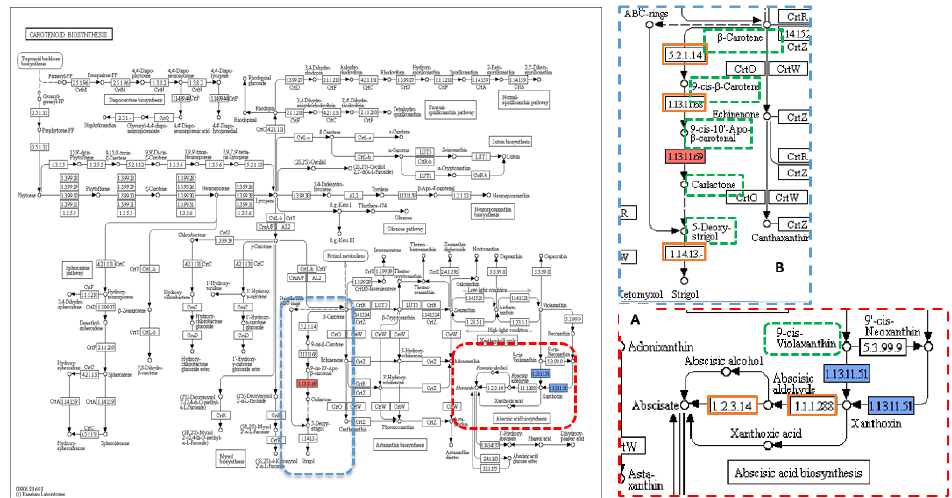
Figure 2. KEGG pathway of carotenoid biosynthesis containing ( A ) abscisic-acid (ABA), and ( B ) strigolactones (SLs) biosynthetic pathways. KEGG pathway of carotenoid biosynthesis containing ( A ) abscisic-acid (ABA) biosynthetic pathway (dotted red box) and ( B ) strigolactones (SLs) biosynthetic pathway (dotted blue box), dotted green squares: precursors and substrates included in ABA and SLs biosynthesis pathway, solid blue square: OsNCED5 (1.13.11.51-dioxygenase) enzyme encoded by LOC107275952 and/or LOC107275432 genes carrying the trait-associated variants (TAVs) identified in this study, solid red square: CDD8 (1.13.11.69-synthase) enzyme encoded by D10 gene carrying the TAVs identified in this study, and orange squares: other enzymes involved in the pathway. Reprinted with permission from Kyoto Encyclopedia of Genes and Genomes (KEGG), http: // www.kegg.jp / kegg /